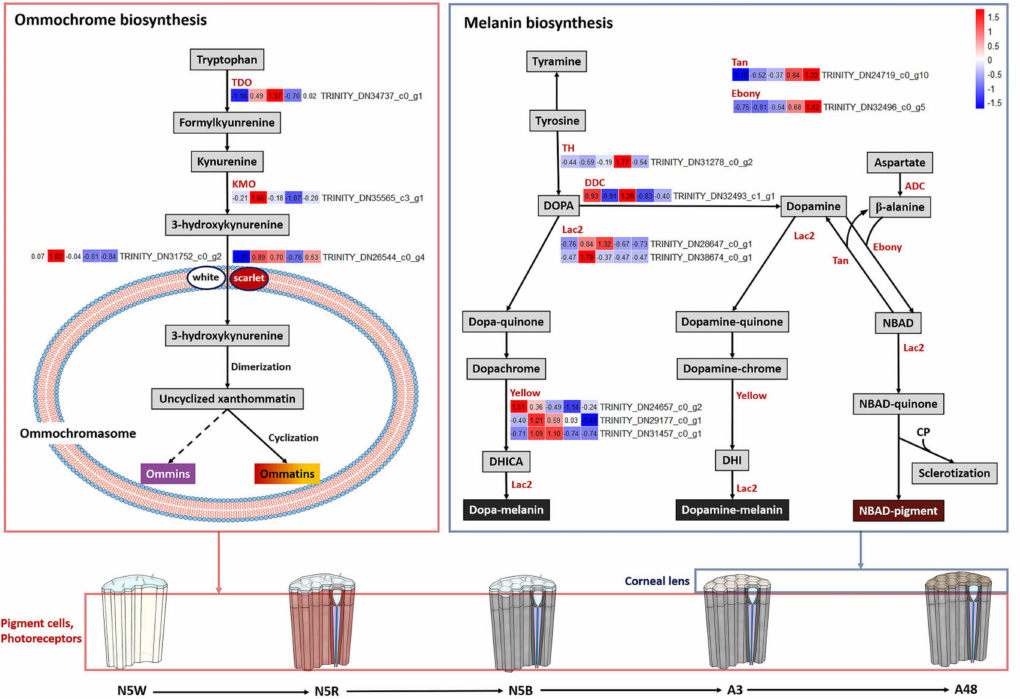
Figure 3. Expression patterns of key DEGs related to pigmentation. Ommochrome biosynthe- sis pathway is related to the genes encoding tryptophan 2,3-dioxygenase (TDO), kynurenine 3- monooxygenase (KMO), two ABC transporters (white and scarlet). Melanin biosynthesis pathway is related to the genes encoding tyrosine hydroxylase (TH), NBAD hydrolase (Tan), NBAD synthase (ebony), DOPA decarboxylase (DDC), aspartate 1-decarboxylase (ADC), laccase (lac2, two genes), and yellow protein (three genes). The heatmaps based on TPM show the expression levels of the corresponding protein or enzyme genes in five development stages (From left to right, the 5th-instar with white compound eyes (N5W), with red compound eyes (N5R), with dark brown compound eye (N5B), the adults after emergence at 3 h (A3), 48 h